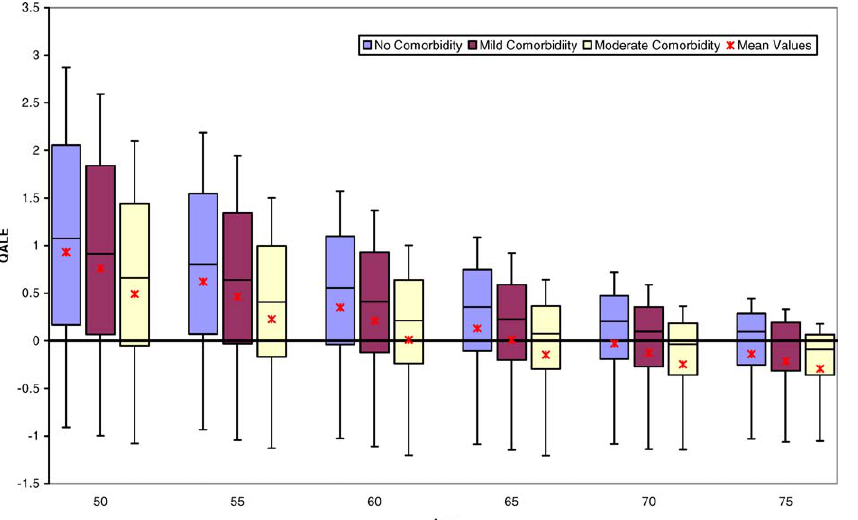
Figure 4. Box plot of Gain in QALE with Immediate Cystectomy by Age and Comorbid Status for Male Patients The region in the shaded boxes represents the interquartile range. The solid line within boxes is the median incremental gain, whereas the mean value is presented as an asterisk. Upper and lower whiskers indicate the 10th and 90th percentiles,